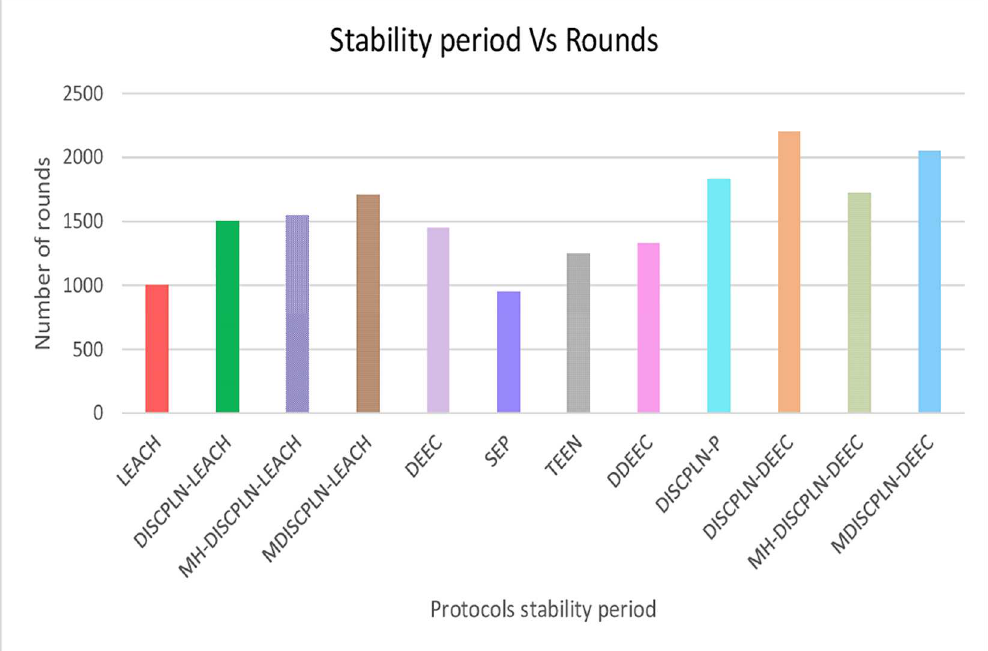
Fig 17. Performance comparison on the basisof network